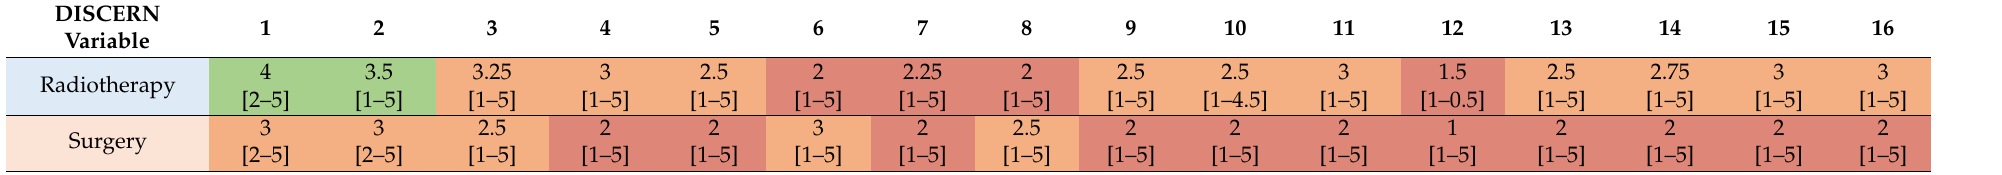
Table 2. DISCERN single items (median [range]) for the different treatment methods